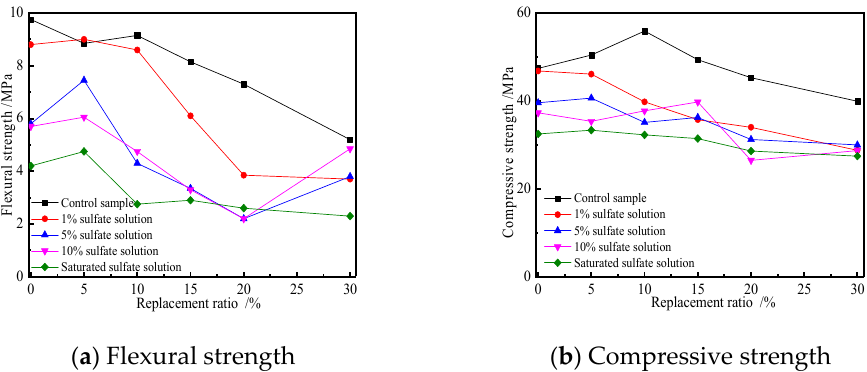
Figure 3. Variation of mortar strength with replacement ratios of cement by fly ash.